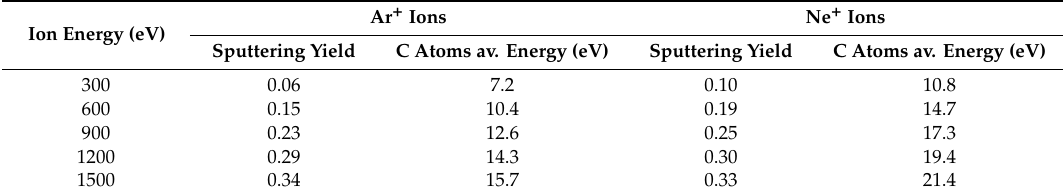
Table 4. Sputtering yield and average energy of carbon under bombardment with Ar + and Ne + as a function of the ions’ energy, as calculated with the software package